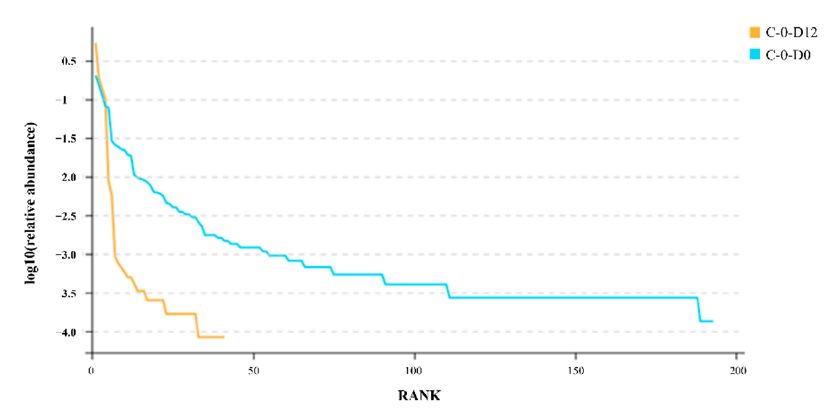
Figure 4. Shannon rarefaction plot ( a ) and species Venn diagram ( b ) of each sample.